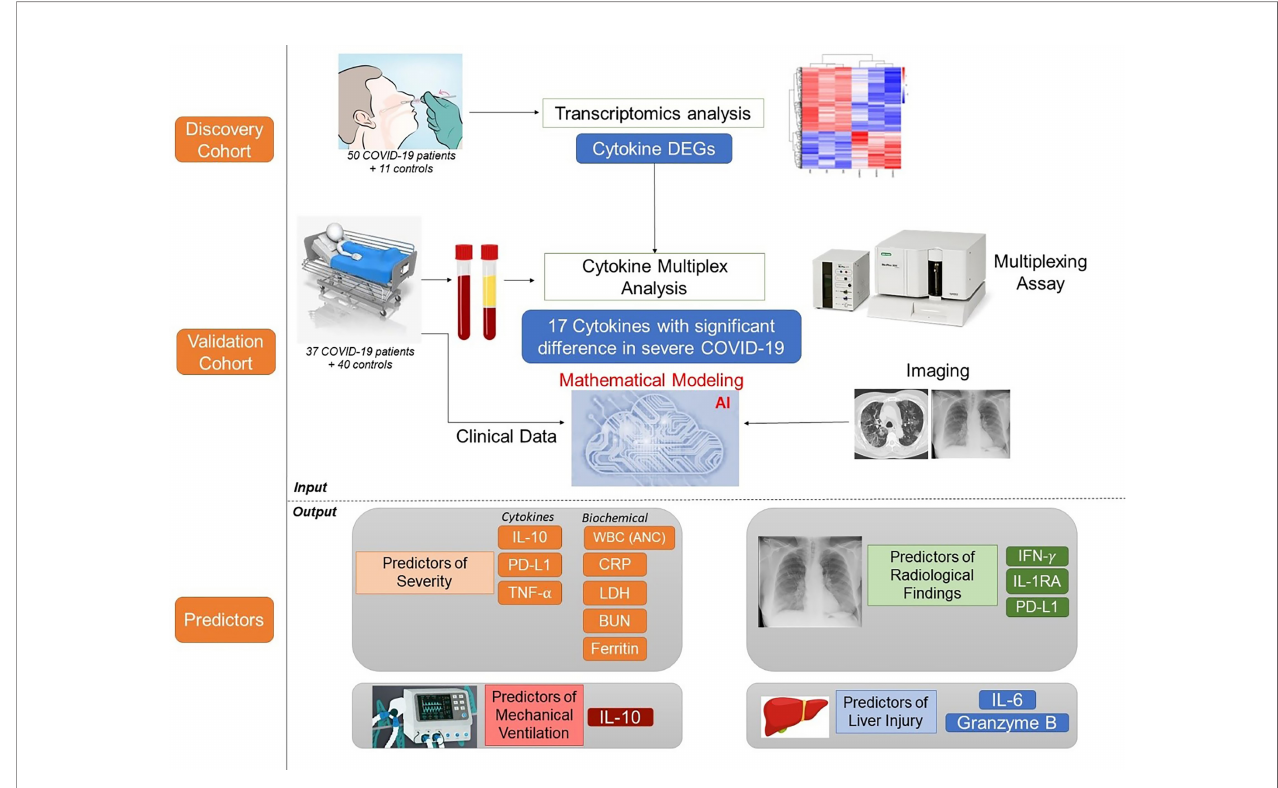
FIGURE 6 | Graphical Abstract of the work fl ow and the main